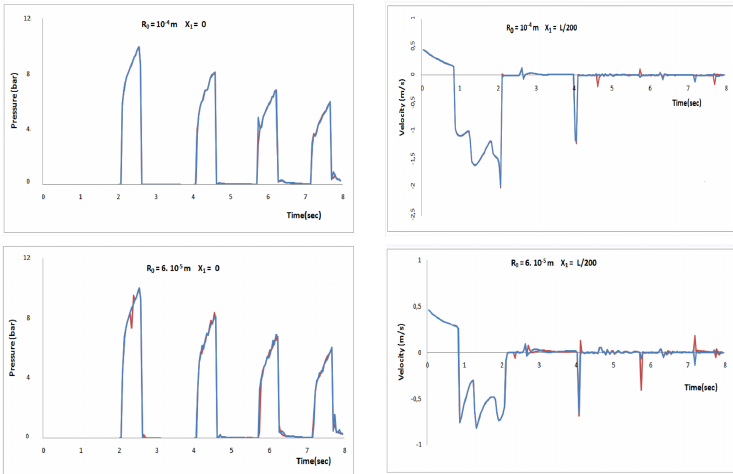
Figure 1. Comparison between the numerical schemes (4.2) and (4.3) for Air/Water mixture with dissolved gas concentration